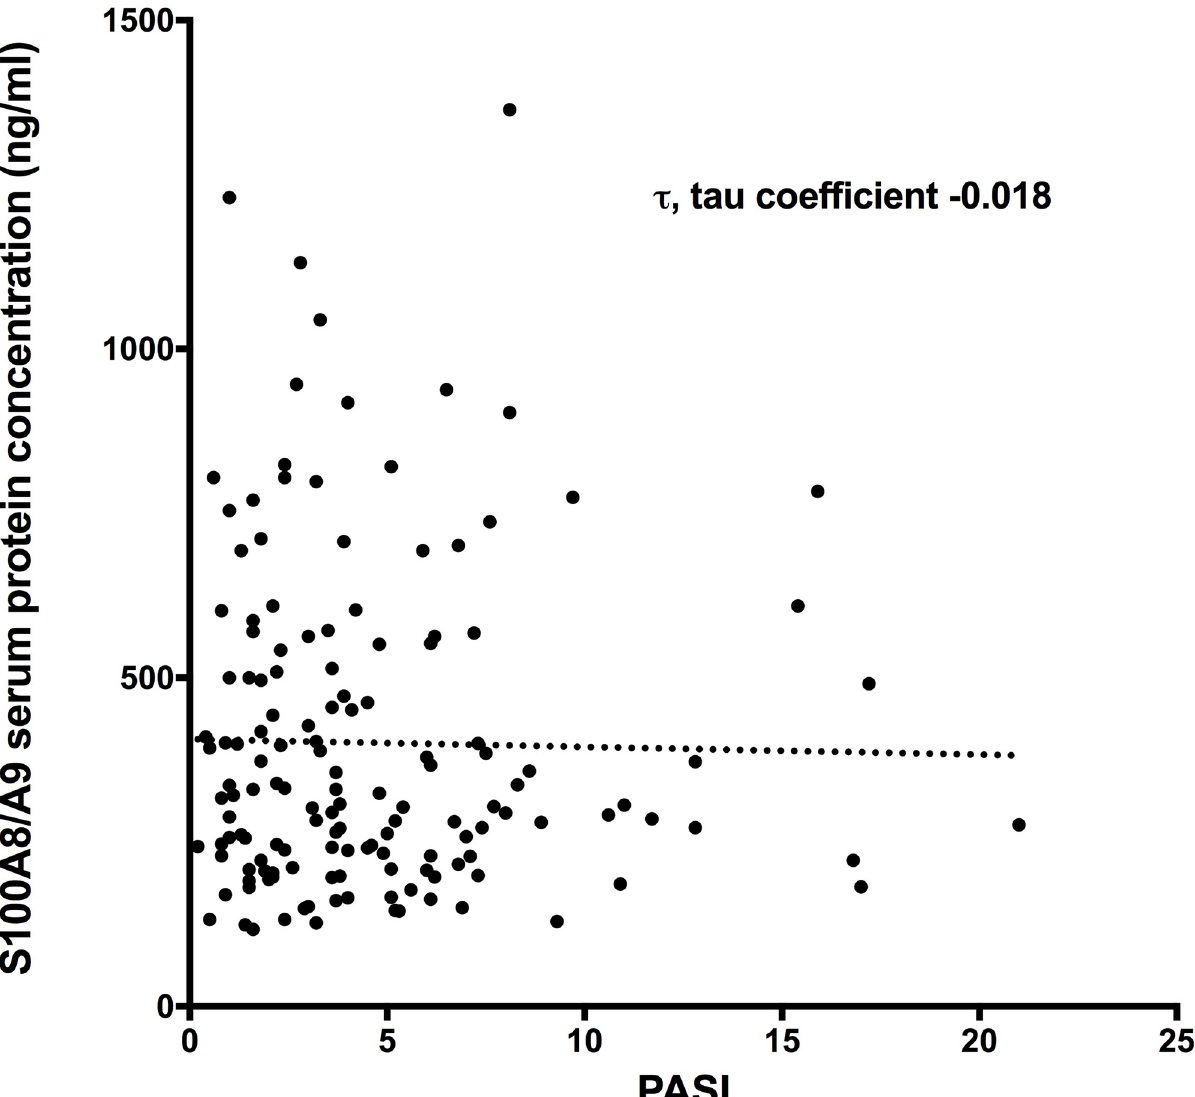
Fig 6. Psoriasis severity (PASI) and serum S100A8/A9 protein levels before, during and after NB-UVB treatment. No correlation was found between PASI and serum S100A8/A9 protein.